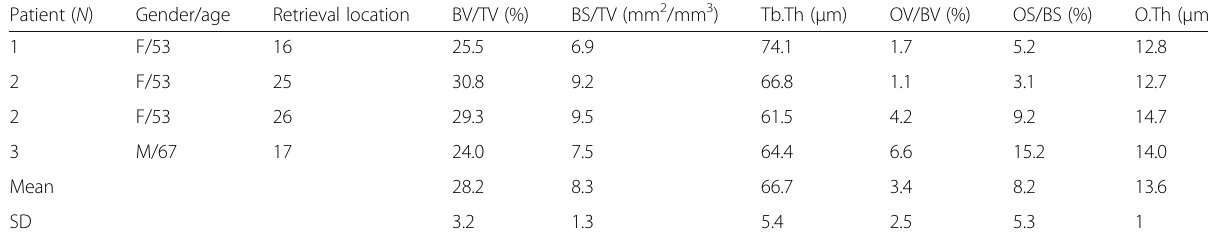
Table 4 Histomorphometric evaluation of the biopsies after a 12-month healing time Patient ( N